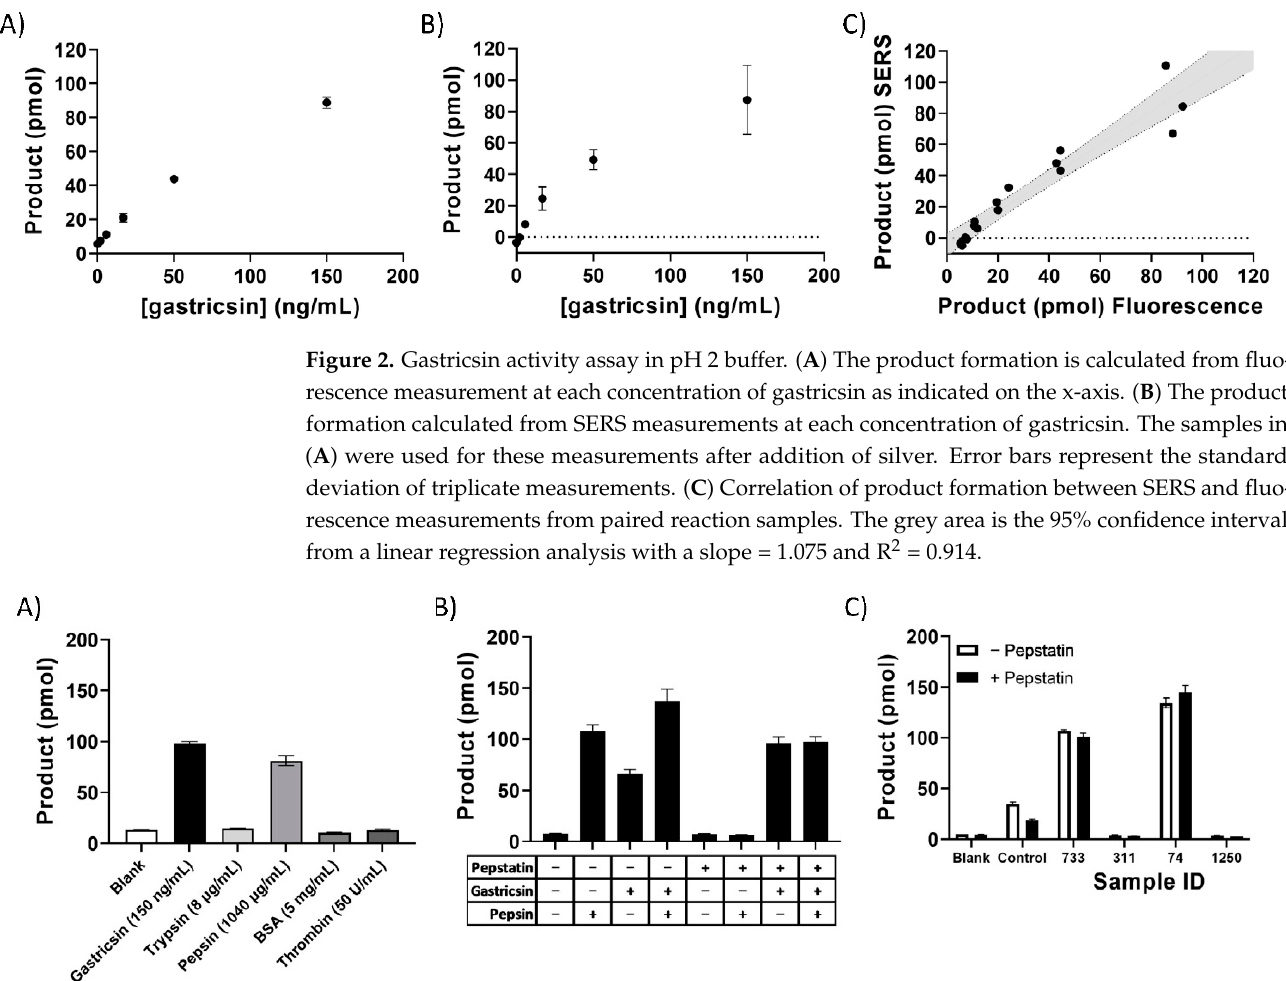
Figure 3. Specificity of assay for gastricsin. ( A ) Activity of VS001 substrate loaded onto beads with proteolytic enzymes and bovine serum albumin (BSA). Concentrations for each analyte are listed in parentheses. ( B ) Impact of 50 nM pepstatin on activity of 150 ng/mL gastricsin and/or 1 µg/mL pepsin in assay as indicated in the table below where “+” indicates addition of analyte. ( C ) Impact of the addition of pepstatin to assay buffer for clinical sample analysis. Controls are mock samples prepared with gastricsin at 150 ng/mL. Error bars represent standard deviation of triplicate measurements.